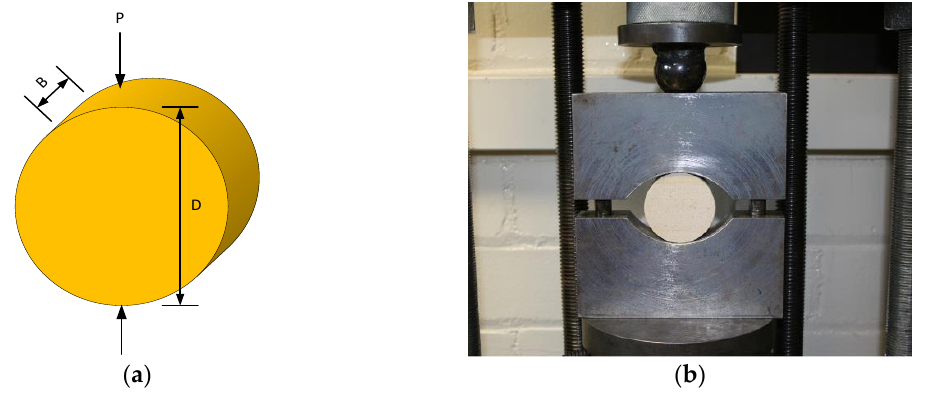
Figure 2. Brazilian tension test: ( a ) specimen geometry; ( b ) test configuration.